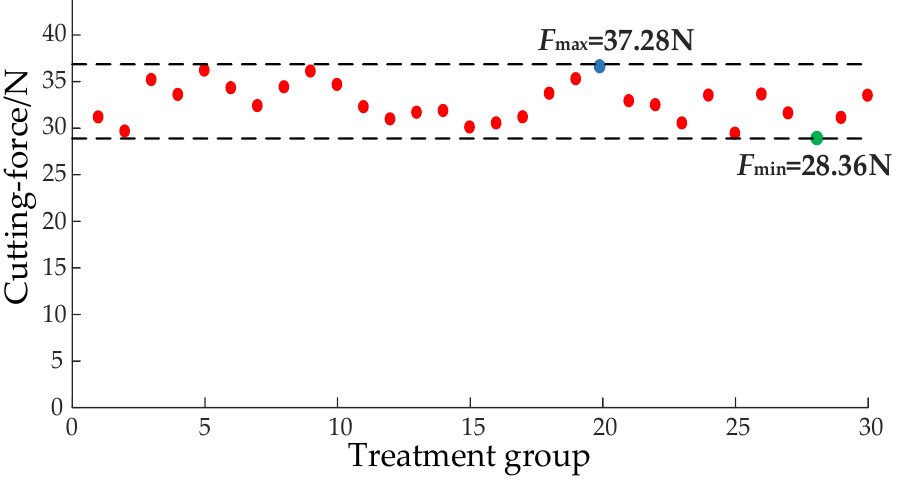
Figure 6. Comparison of pressure damages on broccoli surfaces at different pressures: ( a ) 30 N; ( b ) 40 N; ( c ) 50 N.